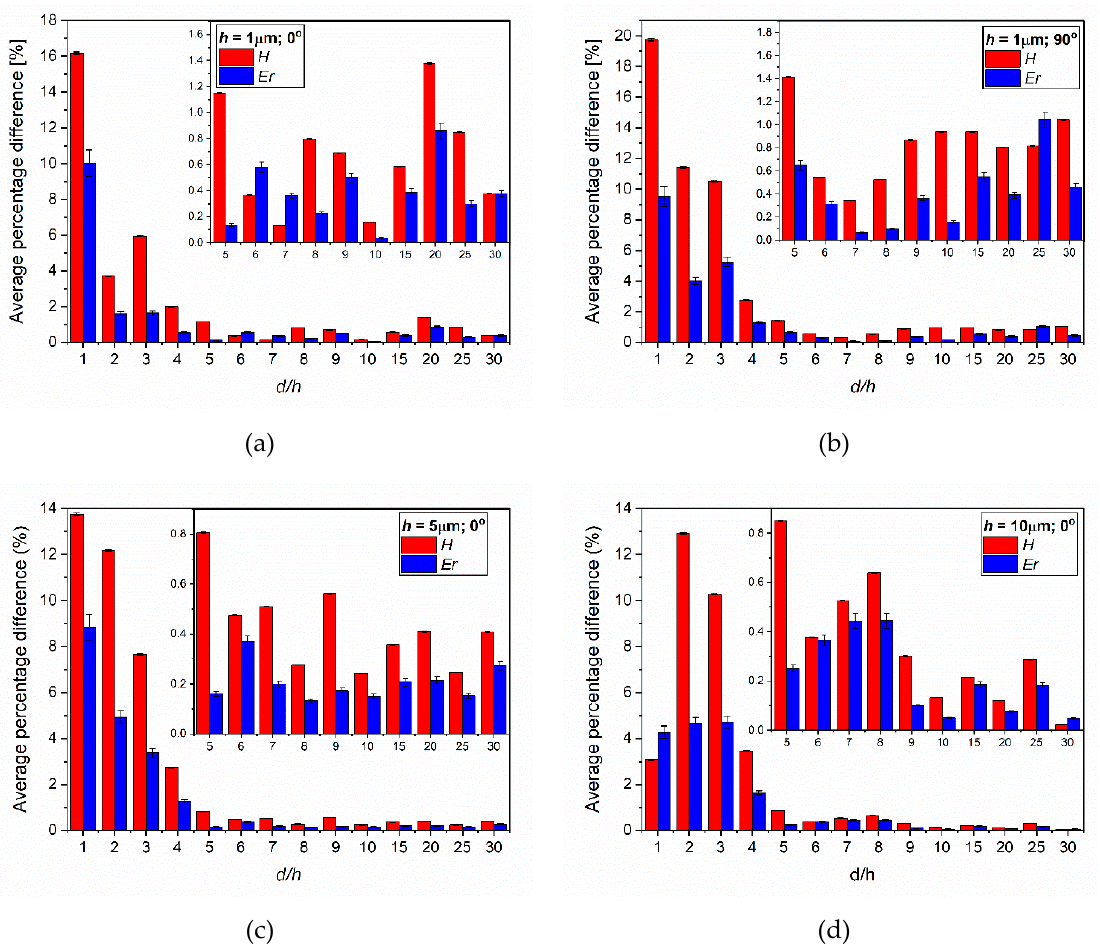
Figure 5. The average percentage difference values for three indents obtained at the same spacing ( a ) orientation 0°, h = 1 µm; ( b ) orientation 90°, h = 1 µm; ( c ) orientation 0°, h = 5 µm; ( d ) orientation 0°, h = 10 µm.